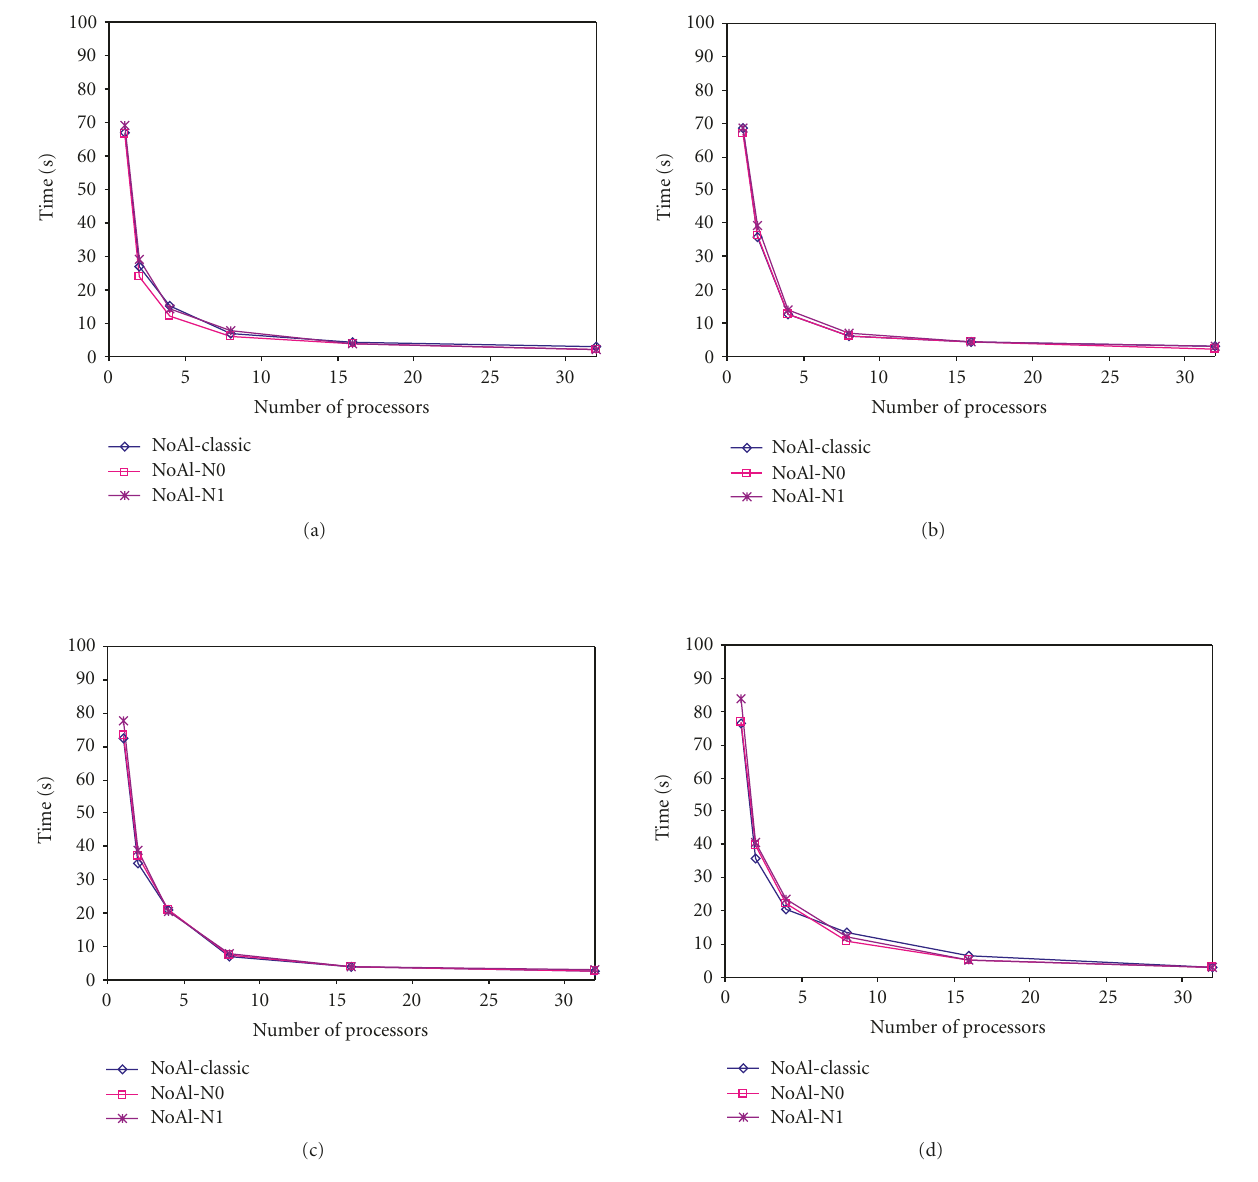
Figure 9: Processing time: frames of 1024 × 1024 pixels (a) 4 frames/GOF, (b) 8 frames/GOF, (c) 16 frames/GOF, (d) 32